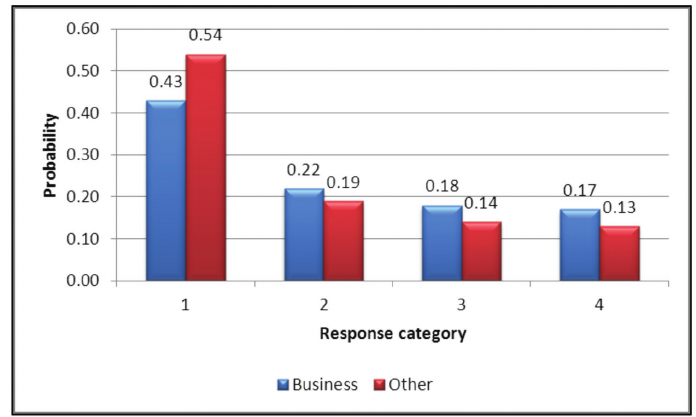
Figure 3: Response category probabilities – Cost of parking (purpose of travel) The dominant probabilities for selecting the lowest response category (1 = to no extent) indicates that business and other travellers are more likely to view the Cost of parking as having no influence on their airport